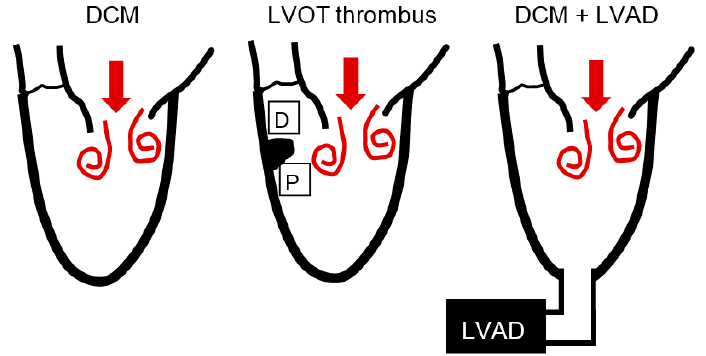
Figure 1. Experimental measurements of left ventricle (LV) flow for a model of dilated cardiomyopathy (DCM), a unique case of an LV with a thrombus in the left ventricular outflow tract (left ventricular outflow tract (LVOT) thrombus), and the addition of left ventricular assist device (LVAD) support were performed using a mock circulatory loop and particle image velocimetry. Regional analyses were calculated for two regions of interest (ROI) in the LVOT, identified as the distal (D) and proximal (P) ROI.